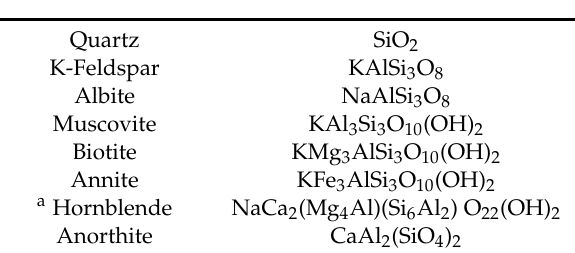
Table 2. Primary granite